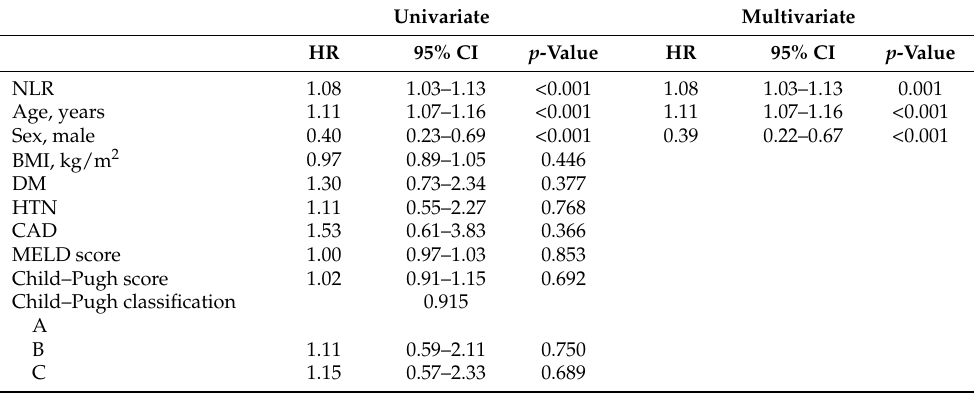
Table 3. Cox regression analysis of risk factors associated with postherpetic